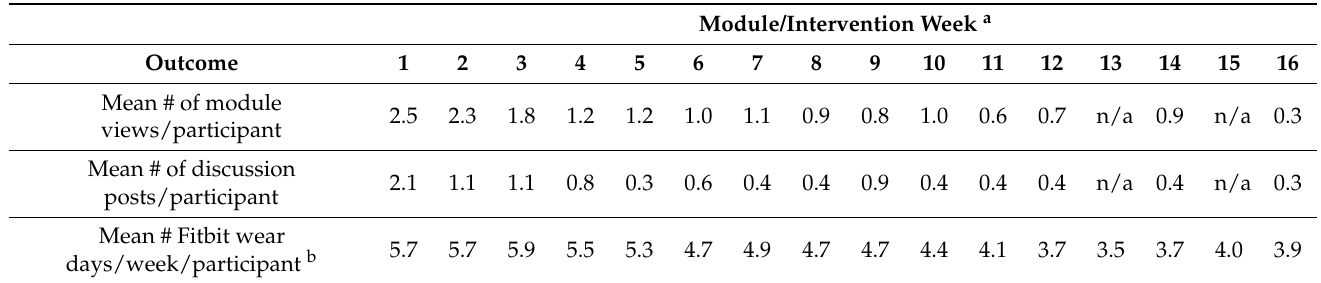
Table 6. Smart Walk App engagement and Fitbit wear among participants allocated to the PA intervention (n = 30).